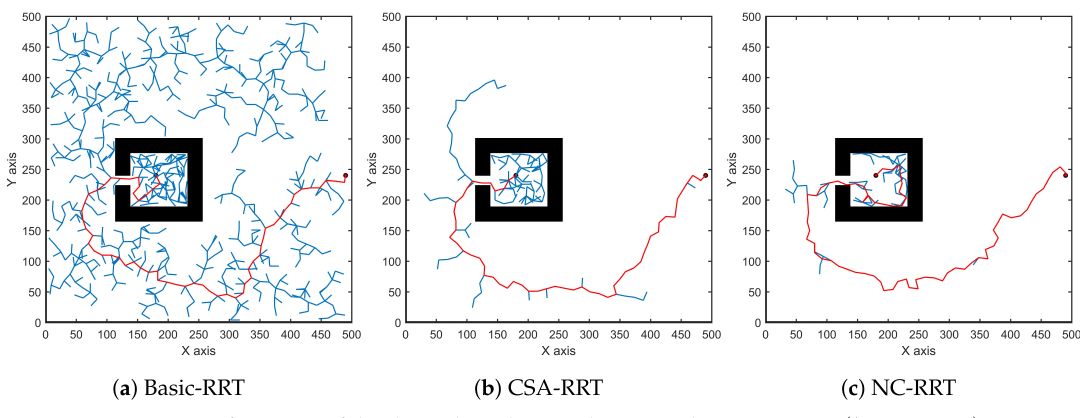
Figure 6. Performance of the three algorithms in the trapped environment. ( k = 3, c = 2 ) .